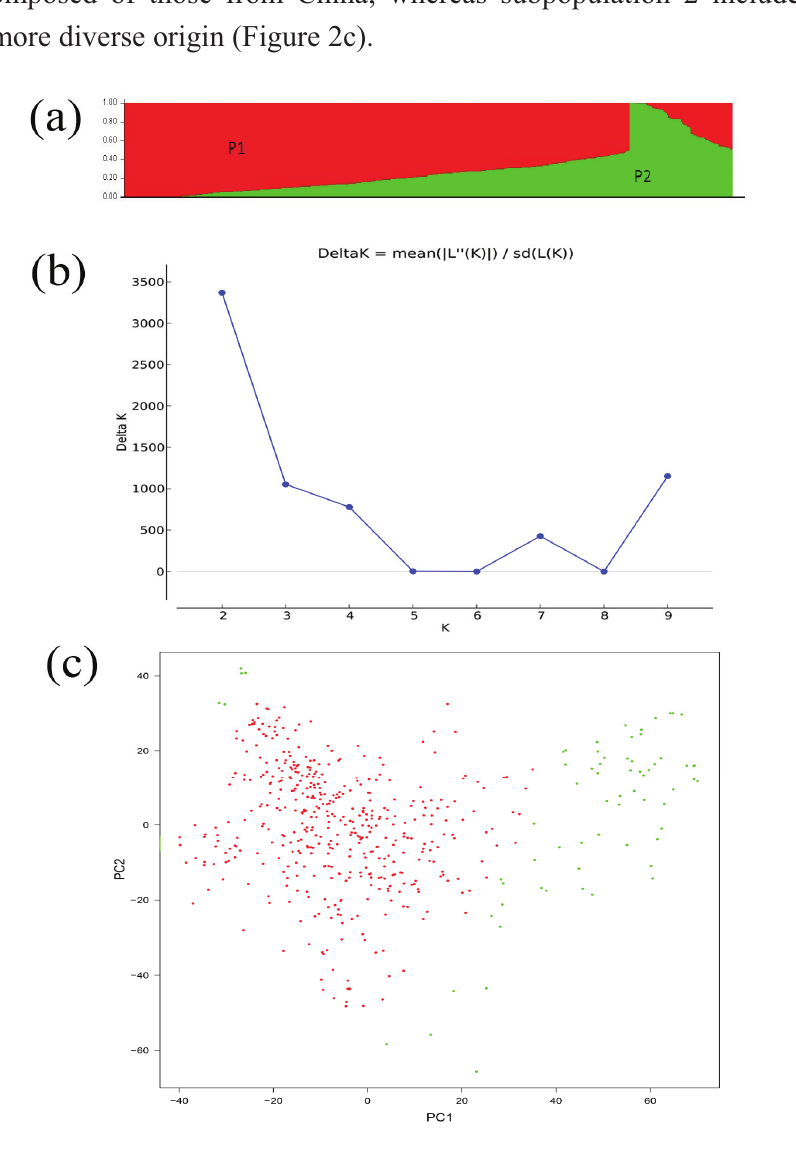
Figure 2. Analysis of the population structure of 520 rapeseed accessions. ( a ), Model-based Bayesian clustering performed by STRUCTURE 2.1 for K = 2 subpopulations (Red indicates subpopulation P1 genotypes and green represent subpopulation P2); ( b ), (cid:2)K based on rate of change of LnP (K) between successive K values; ( c ), The sub-populations in a population of 520 B. napus accessions, suggested by Principal Coordinate Analysis